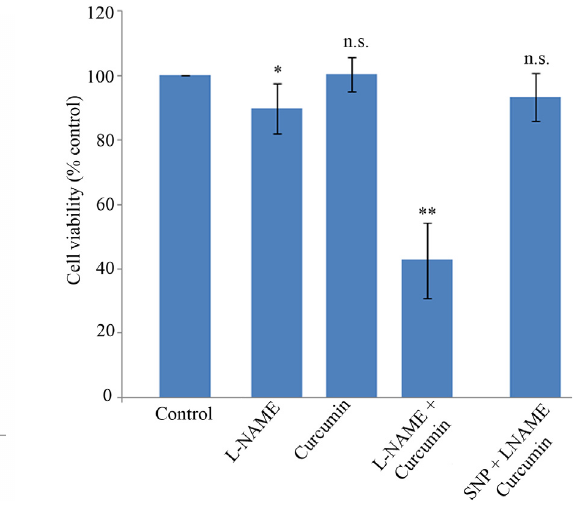
Figure 1. ( a ) Concentration-dependent effect of curcumin on MG-63 cells viability. Cells were incubated with various concentrations of curcumin for 24 h, after which cell